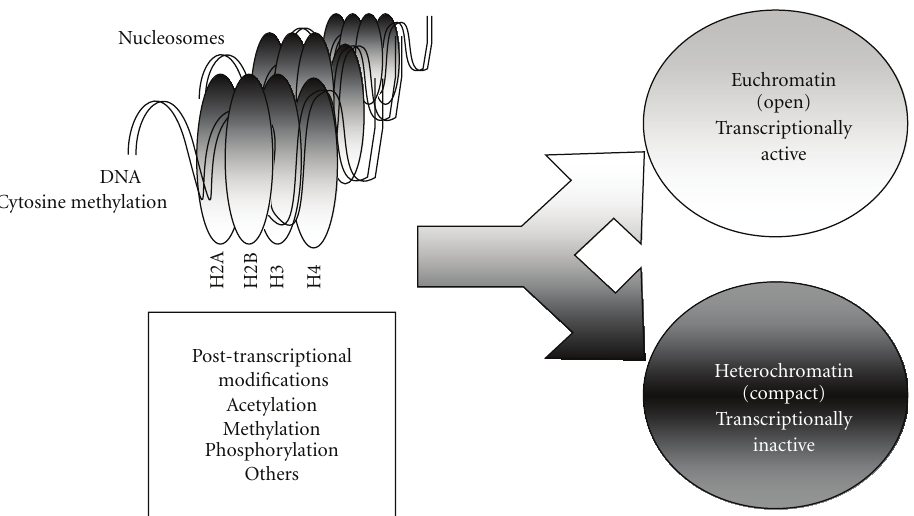
Figure 1: The basic chromatin unit or nucleosome consists of a protein octamer containing two molecules of each histone (H2A, H2B, H3 and H4), around which DNA is wrapped. The arrangement of nucleosomes can be altered by posttranscriptional modification of histones, that could be associated to heterochromatin, highly compacted silenced chromatin, or euchromatin, transcriptionally active open chromatin.